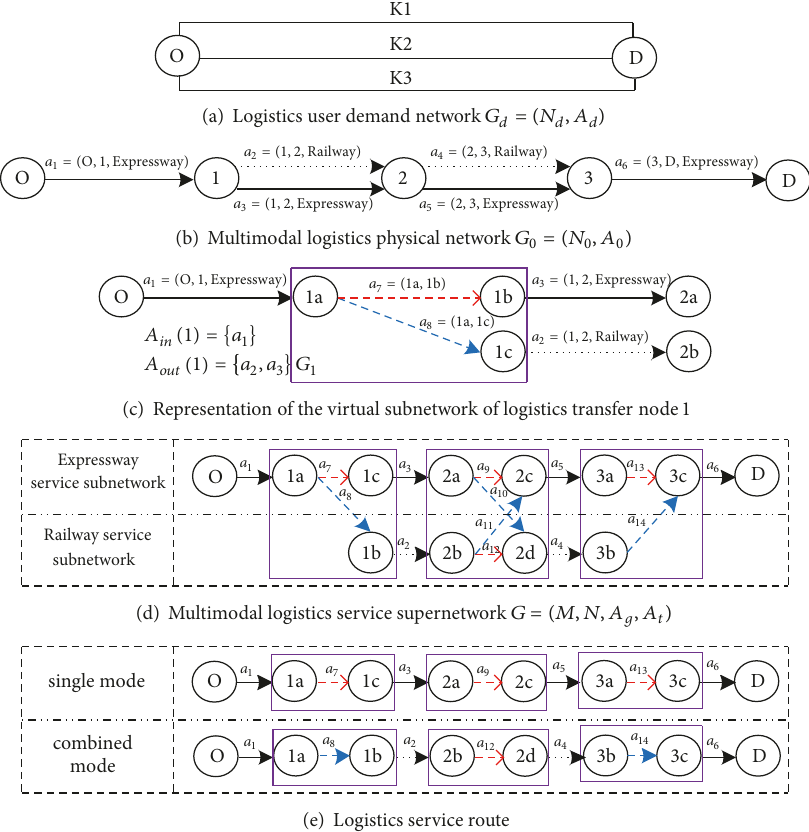
Figure 1: Multimodal logistics network